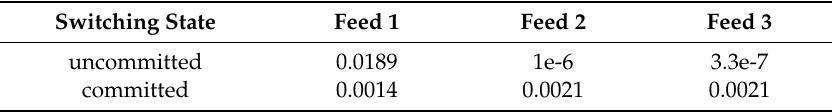
Table 2. Standard deviation of the feeder node voltage.